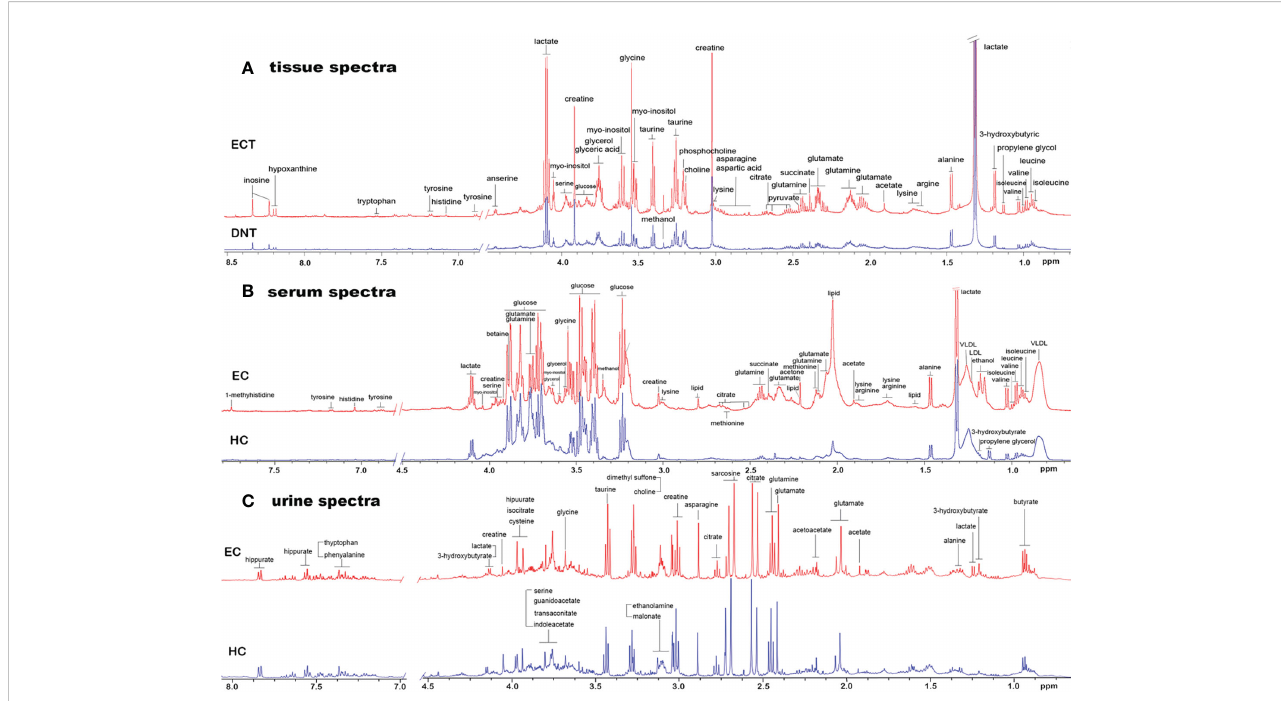
FIGURE 1 Representative 1D 1H NMR spectra of tissue, serum and urine from EC patients and controls. (A) Representative 600MHz NOESYPR1D 1H NMR spectra of esophageal tissue extracts from ECT and DNT. (B) Representative 600MHz CMPG 1H NMR spectra of serum from EC and HC. (C) Representative 600MHz NOESYPR1D 1H NMR spectra of urine EC and HC. ECT, esophageal cancer tissue; DNT, distal noncancerous tissue; EC, esophgeal cancer; HC, healthy